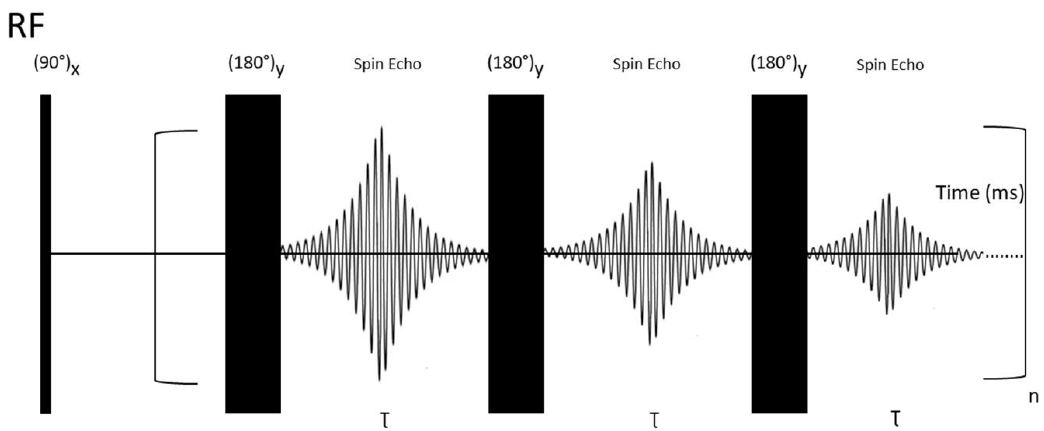
Figure 5. CPMG pulse sequence. First, a 90 ◦ RF pulse is applied and results in transverse magnetization in the xy plane. Then a 180 ◦ y pulse is applied to re-phase the magnetization vectors. After 180 ◦ y , the vectors who were faster during the dephasing are overtaken by the slower vectors, which results in re-phasing and generation of a spin-echo signal. This process is repeated several times.